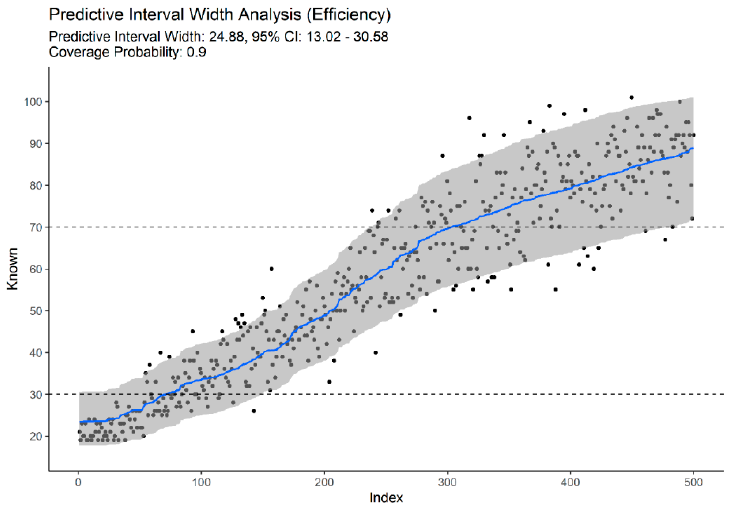
Figure 5. Predictive efficiency of full traits, DRNN-RUM model, α = 0.1. Table 2. Monte Carlo cross-validation metrics for DRNN models built on pre-specified skeletal traits sets.